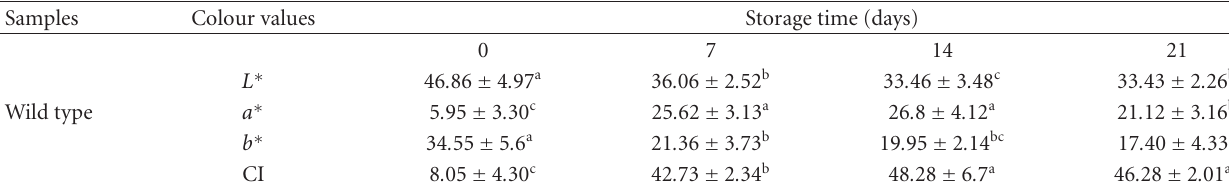
Table 2: Colour data for tomato cultivar wild type during 21 days of